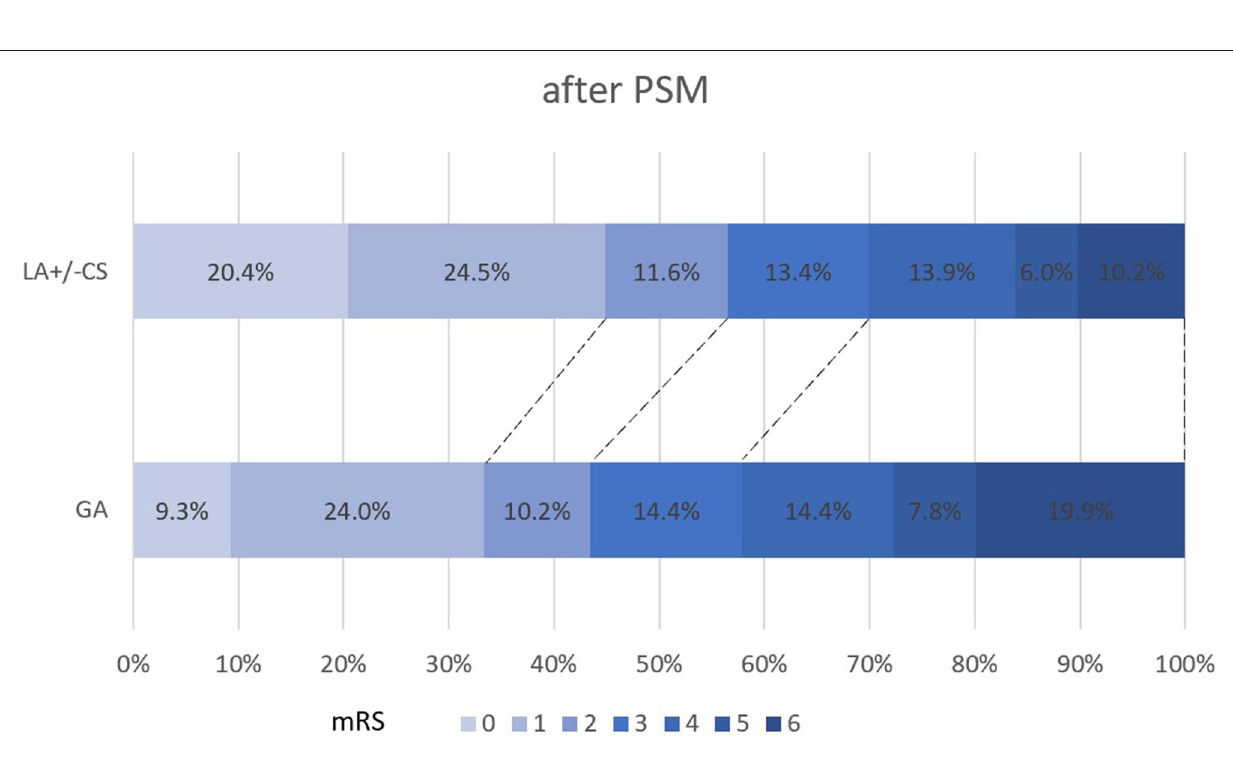
Frontiers in Neurology |